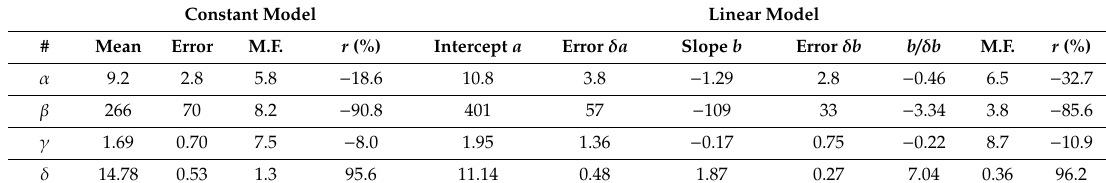
12 of 16 Figure 8. (Left) Diagrams of the modified p -value and reduced chi-square characterizing the linear fitting of the parameters α (a) , β (b) , γ (c) , and δ (d) , with MßCD plotted, as a function of the multiplication factor (M.F.). We identify the M.F. value, for which the corresponding p -value and reduced chi-square are optimized. The goodness of fit is shown using both the modified p -value and reduced chi-square. (Right) Here, the goodness of fit is shown using the unified measure as given by Equation (9) while it is depicted as a function of the signal-to-noise ratio of the slope b/ δ b , characterizing the linear fitting of the parameters with MßCD; (note: Both the ratio b/ δ b and the goodness of fitting are plotted as functions of the multiplication factor (M.F.)). The cases of the parameter α and γ have the optimal values of the p -value and reduced chi-square for │ b/ δ b │ < 1, so that the hypothesis of being dependent on MßCD is rejected. On the other hand, the cases of the